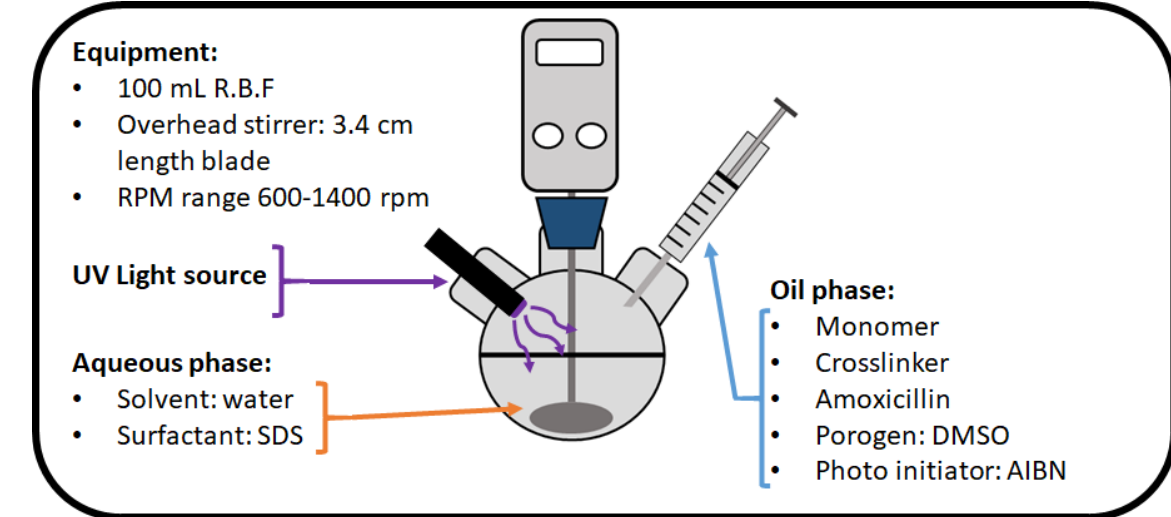
Figure 2. Apparatus schematic for the emulsion polymerization approach of synthesizing MIPs/NIPs with more uniform particle sizes.